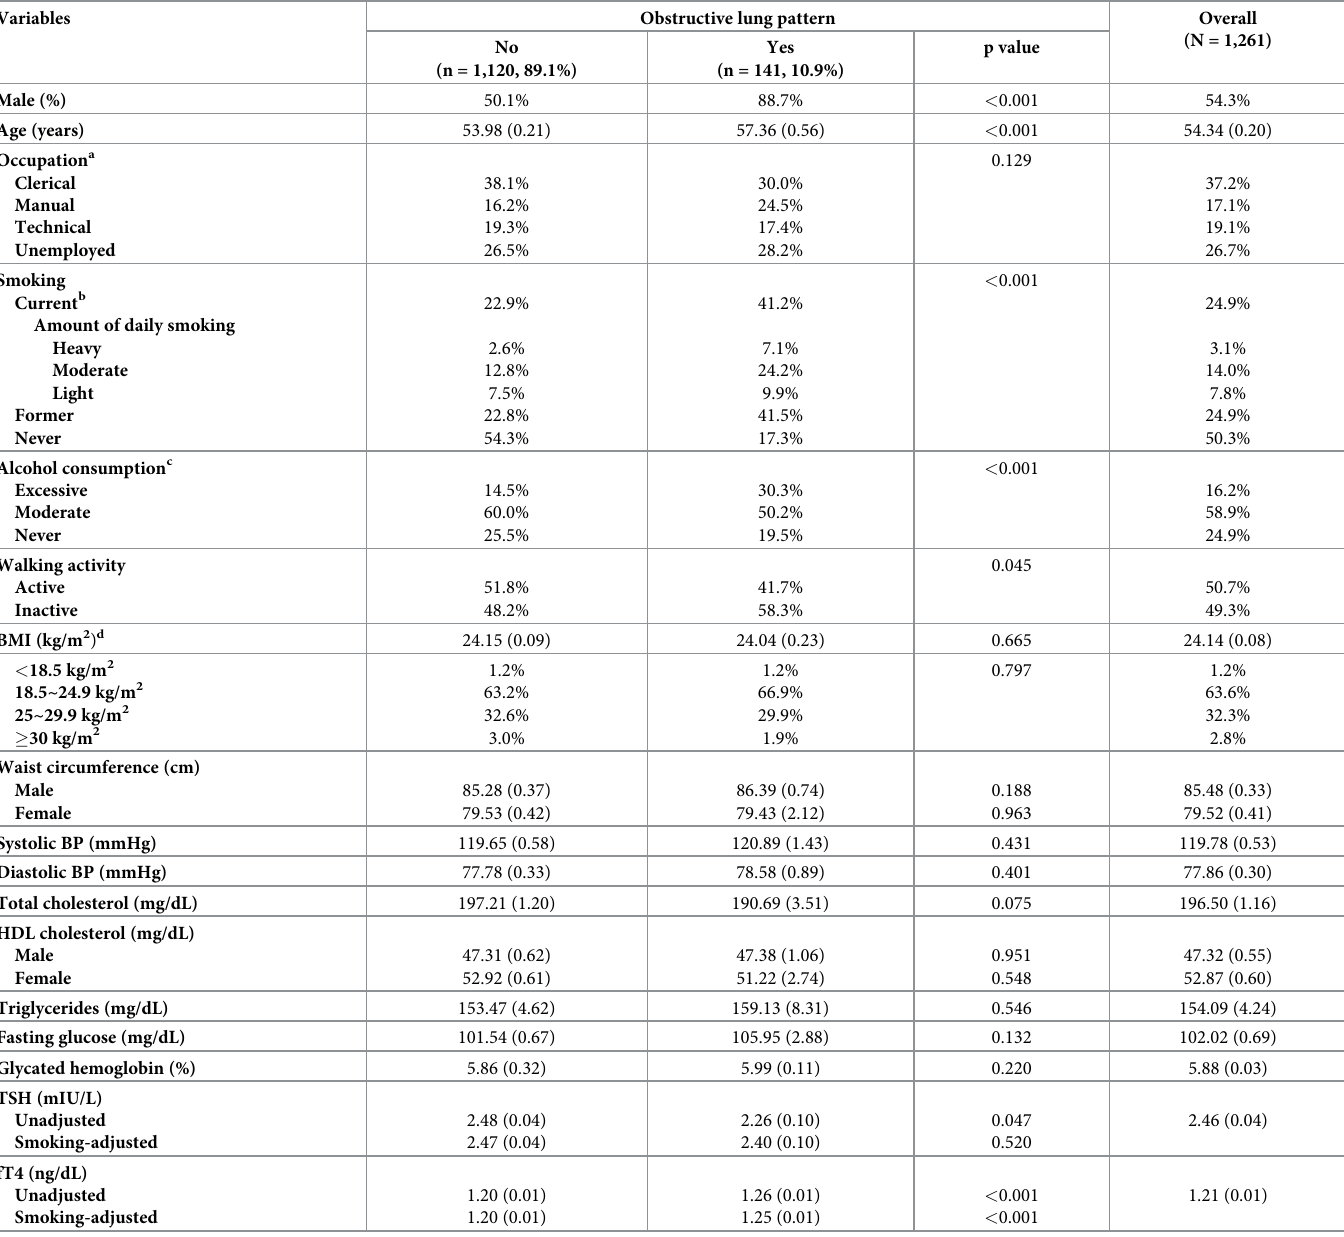
Table 1. Baseline characteristics of study population by the status of obstructive lung